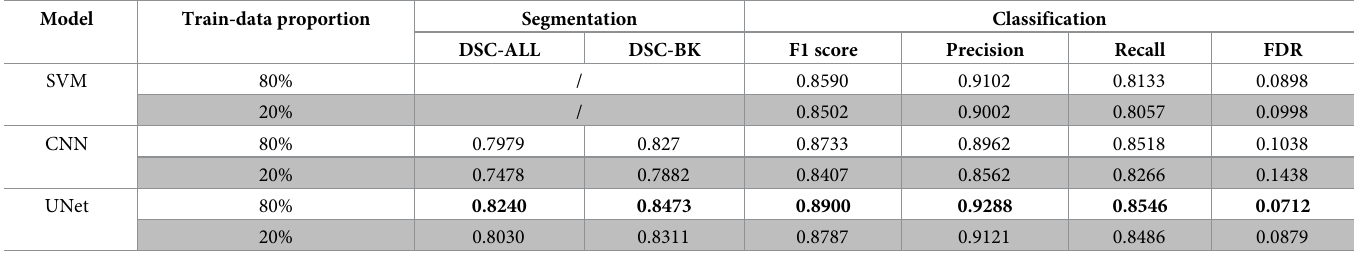
Table 1. 5-fold cross-validation on the simulated data. The average result of 5-repeat runs is reported to reduce the effect of the randomness of GPU training. The results of repeat runs are shown in S3 Table.